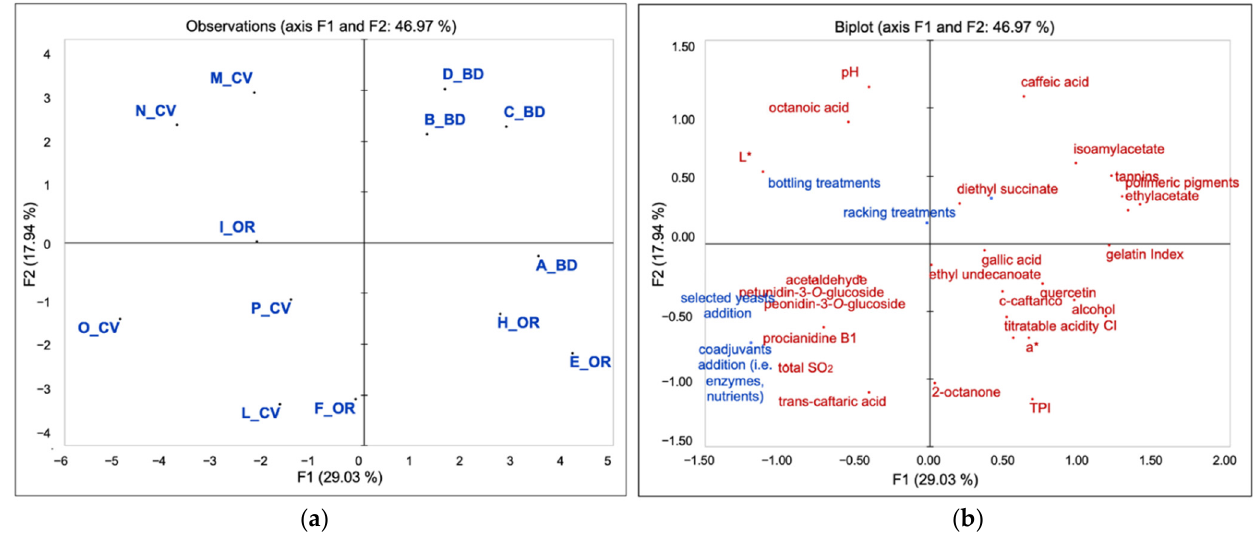
Figure 2. Principal Component Analysis (PCA) of 2016 Chianti wines ( a ) with the significant chemical variables and the survey data (related to the winemaking process) elaborated as supplementary ( b ).